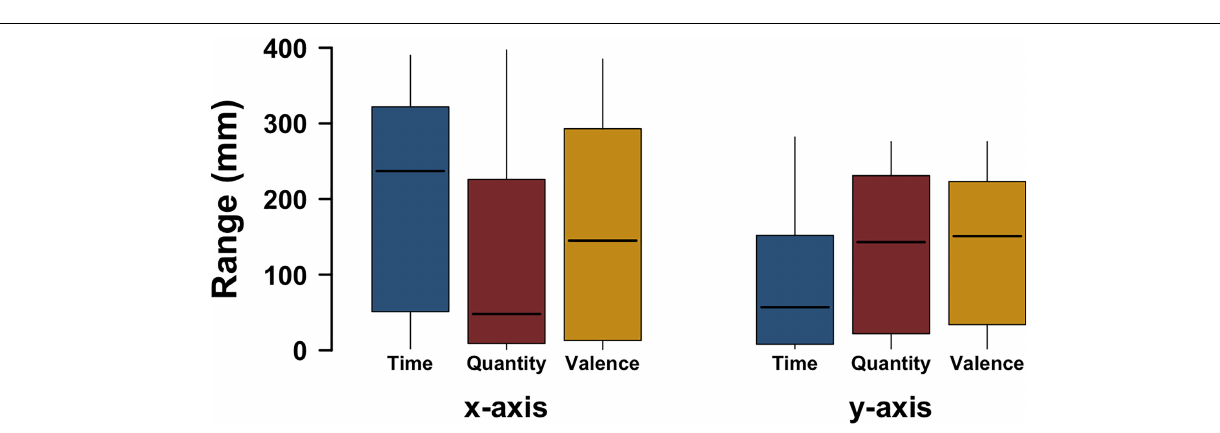
FIGURE 3 | Experiment 2: Range of responses (smallest to largest) along the x -axis and the y -axis for each of the tasks; whiskers represent the largest/smallest number within 1.5 times the interquartile range extending from the